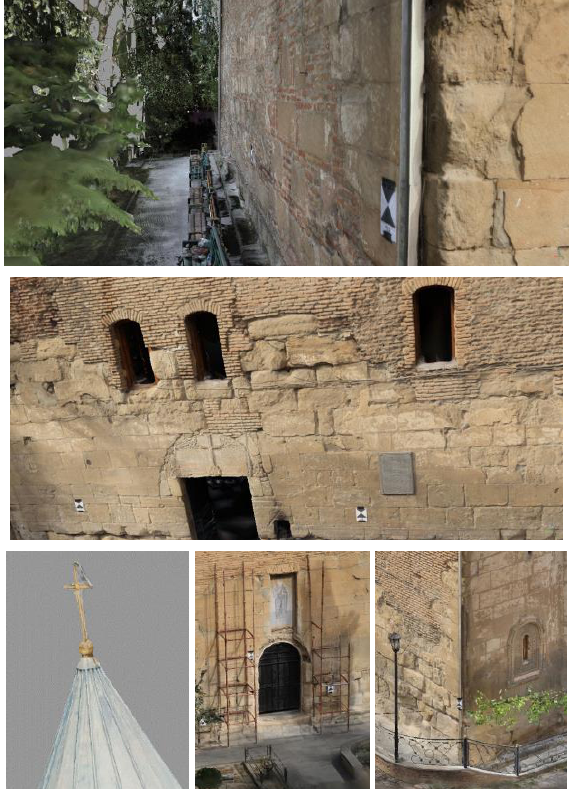
Figure 13. Detailed views from the point cloud calculated with